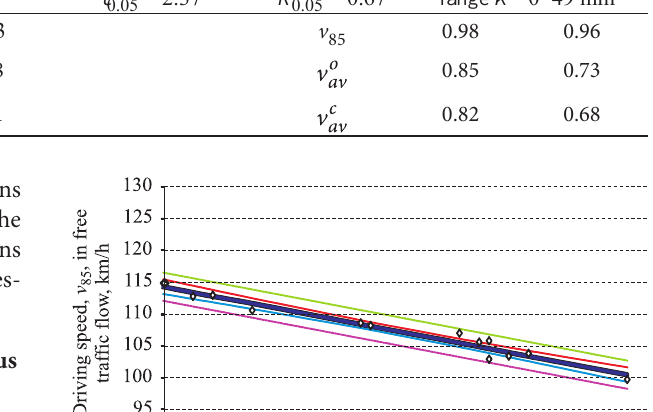
Table 1. Correlation and model coefficients (1) (for various available sight distances) (Sołowczuk 2005) Coefficients of correlation and Speed determination and confidence Available distribution interval sight parameters distance, for free m R R 2 R R 2 traffic flow n = 13 road sections t 0.05 = 2.20 R 0.05 = 0.55 200